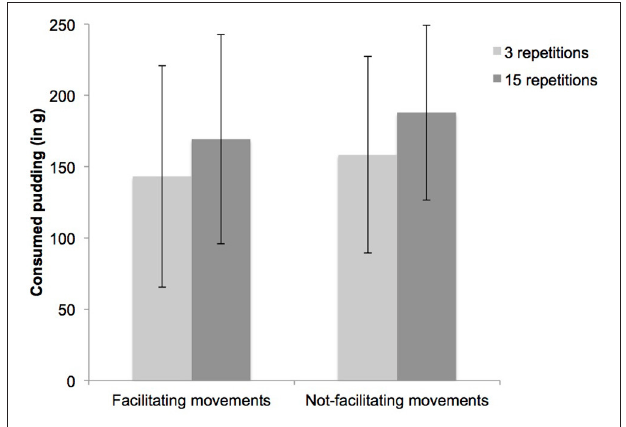
FIGURE 1 | Consumption of chocolate pudding as a function of 15 vs. 3 imagined consumption repetitions and facilitating vs. not-facilitating motor movements